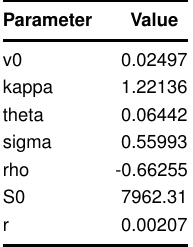
Table 4. Set of used parameters from March 19, 2013.